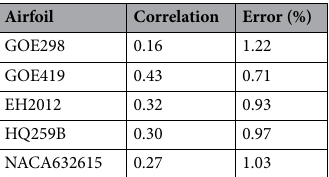
Table 2. Correlation (between the learned weights and the panel length) of different airfoils and prediction